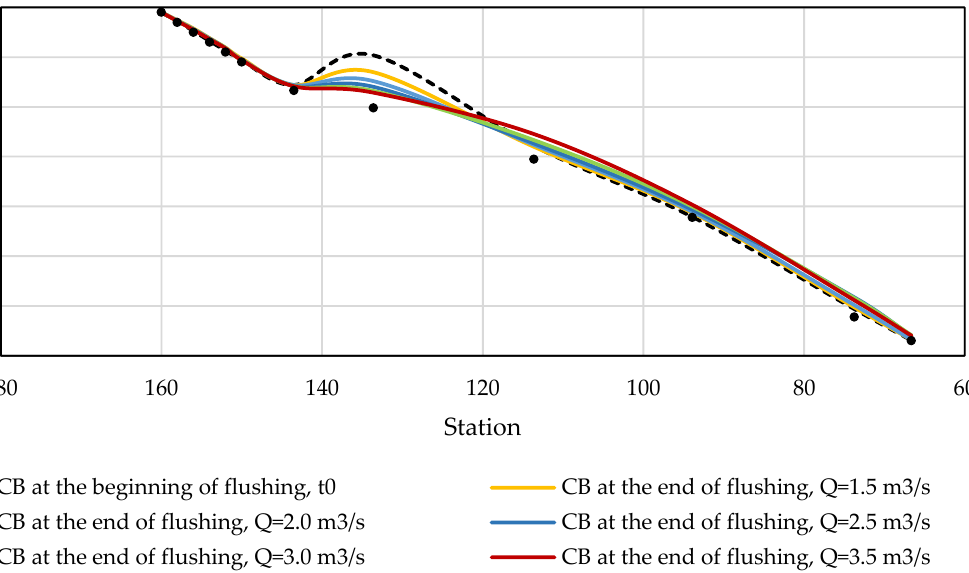
Figure 12. Flushing simulation results (Discharge interval = 0.5 m 3 /s). There are five discharges compared: 1.5, 2.0, 2.5, 3.0, and 3.5 m 3 /s. The upstream and downstream sections of the sand trap are on the left and right sides of the diagram.